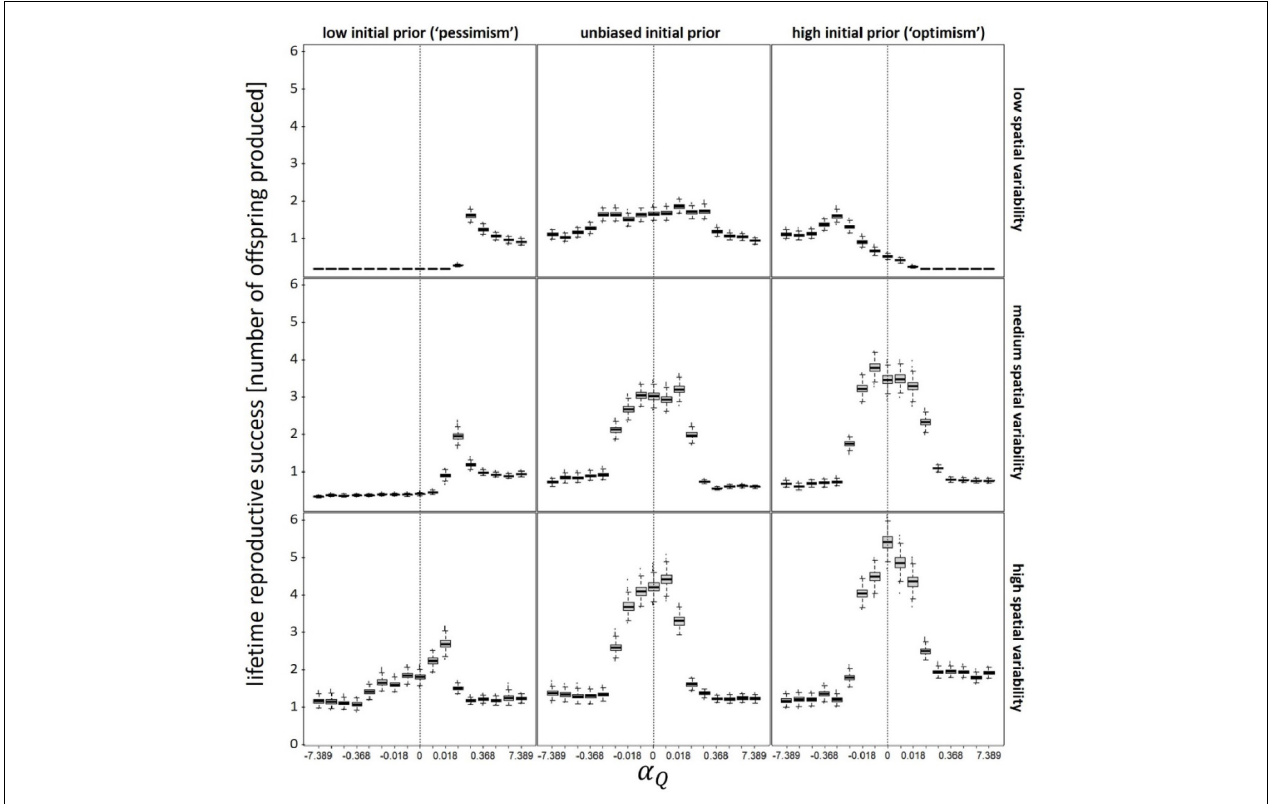
FIGURE 2 | Lifetime reproductive output as function of valence-dependence for patch quality (positive values of α Q correspond to valence-dependent optimism whereas negative values correspond to valence-dependent pessimism). Vertical dashed lines denote unbiased learning ( α Q = 0). Different panels refer to different scenarios: low ( Q ( t = 0) = 50), unbiased ( Q ( t = 0) = 100), and high ( Q ( t = 0) = 150) initial prior belief (columns), and low ( CV ( Q ) = 0.1), medium ( CV ( Q ) = 0.5), and high ( CV ( Q ) = 1) spatial variability (rows). In each scenario, α T was kept constant at its optimal (fitness maximizing) value. T ( t = 0) = b T = 10; CV ( T ) = 0.5; P travel = t max − 1 ; other parameters and variables were as detailed in Table 1